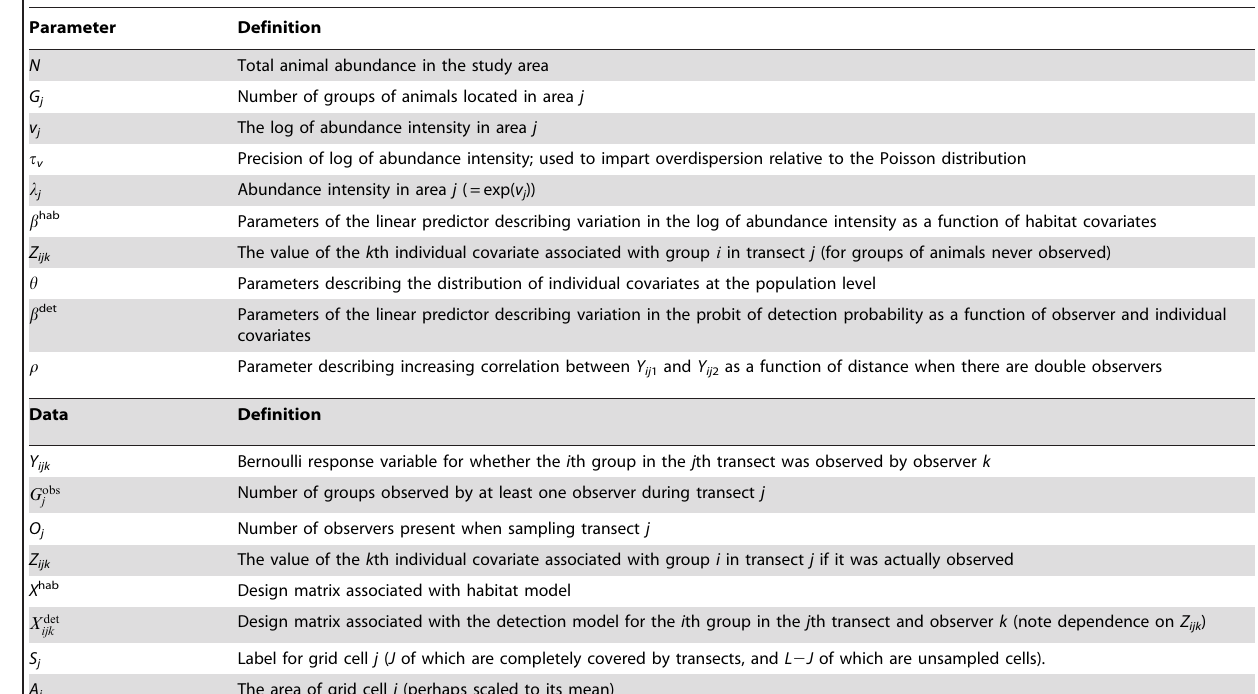
Table 1. Parameter and data